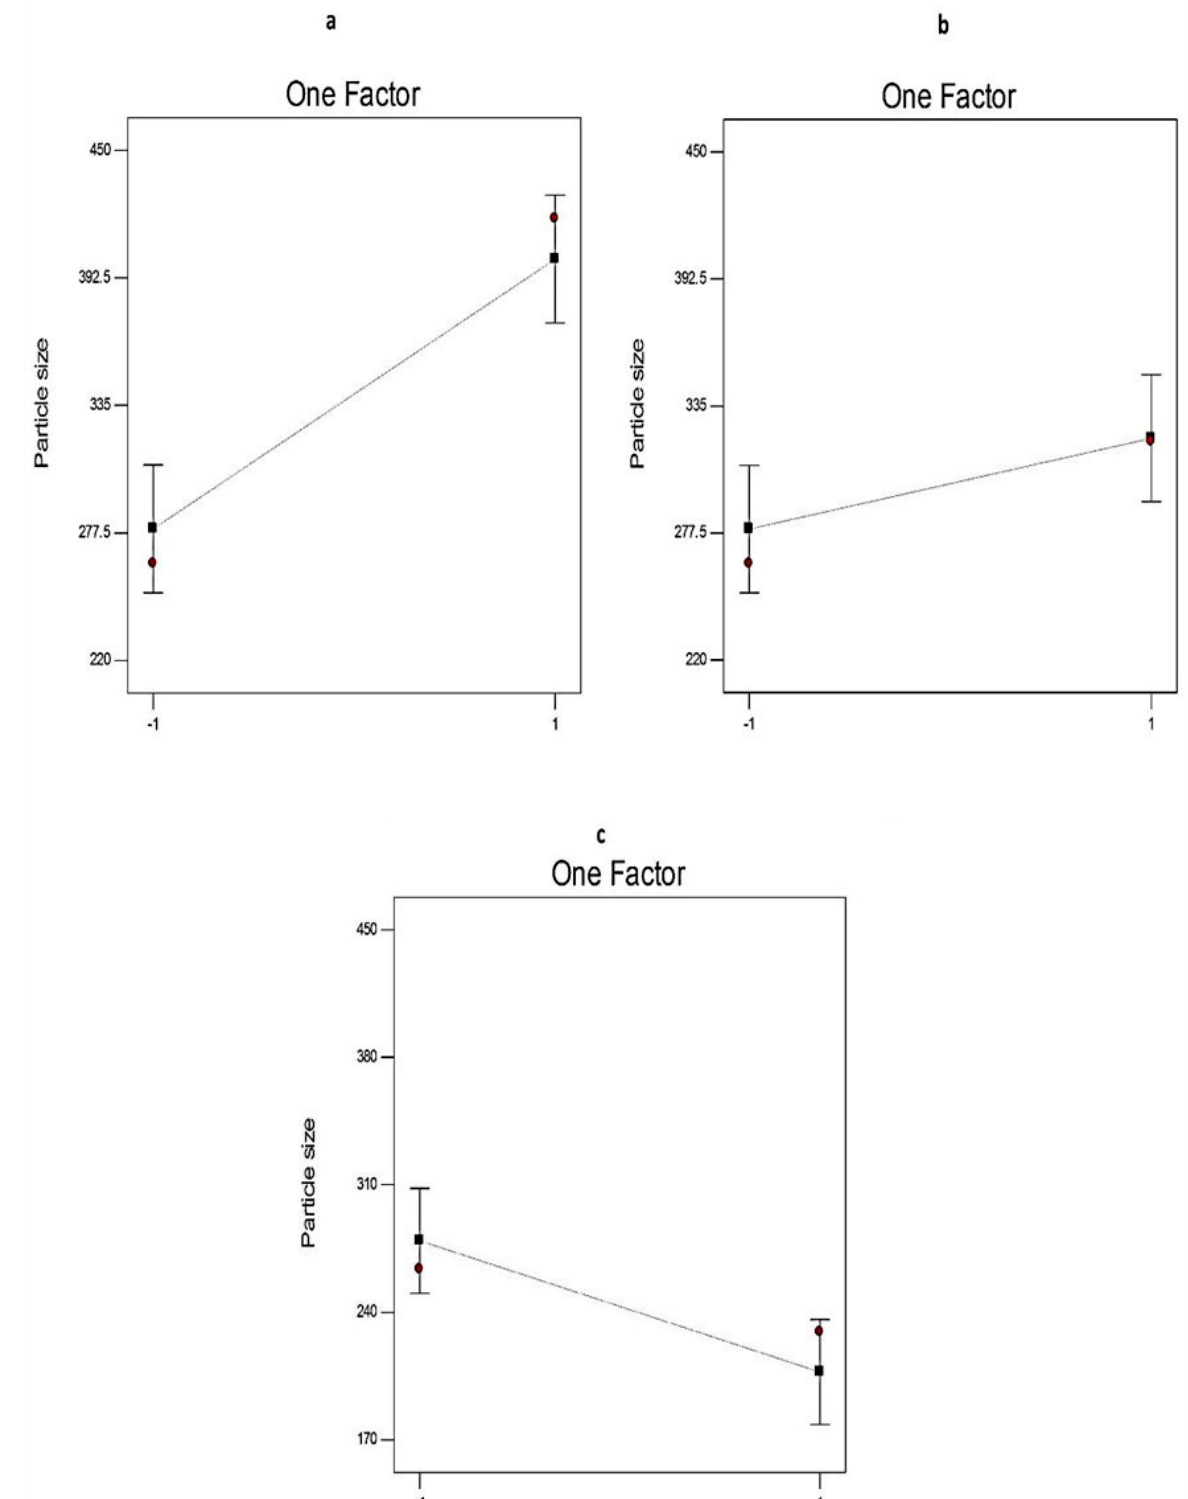
Figure 8. The effect of different independent variables ( a ) on the ratio of Span to EA, ( b ) type of non-ionic surfactant, and ( c ) type of EA on PS of EGCG-loaded spanlastics according to 2 3 factorial design. Abbreviation: PS, particle size; EA, edge activator; EGCG, epigallocatechin